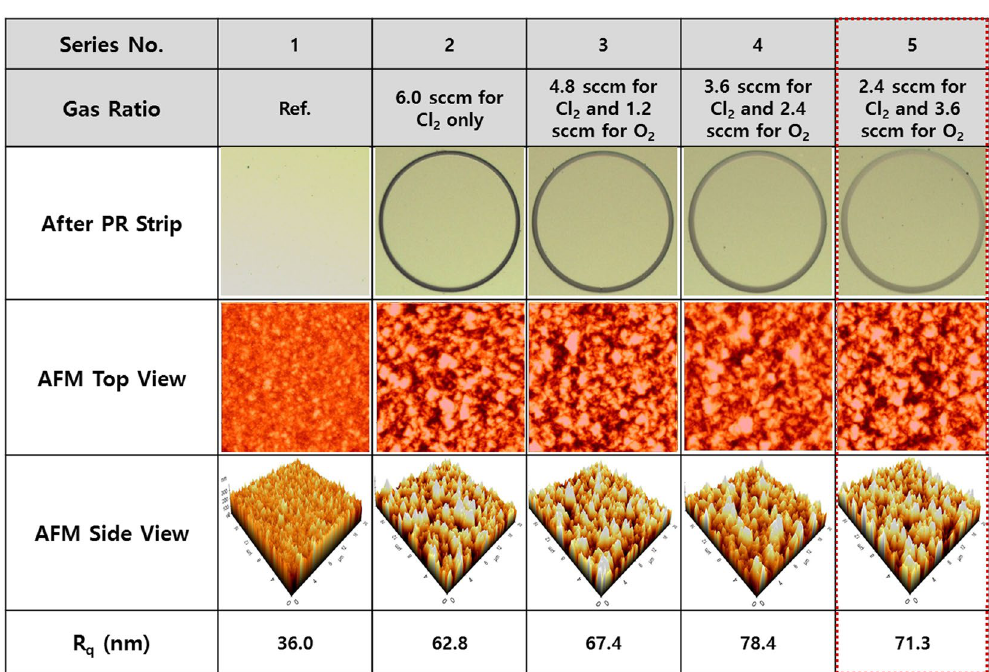
Figure 6. A surface morphological study of the effects of different Cl 2 and O 2 ratios, using atomic force microscopy data. The results suggest that on using an appropriate gas mixture ratio, the resultant surface roughness is acceptable for APD